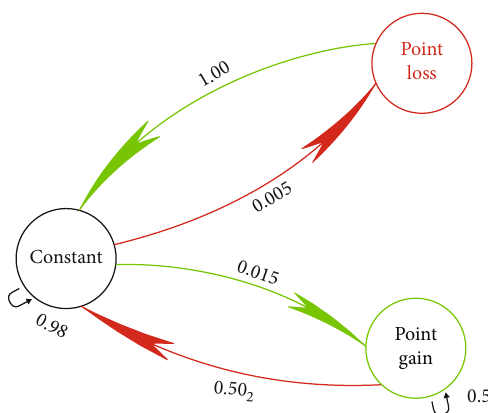
Figure 6: Ecobank Transnational Inc. equity transition matrix and diagram.